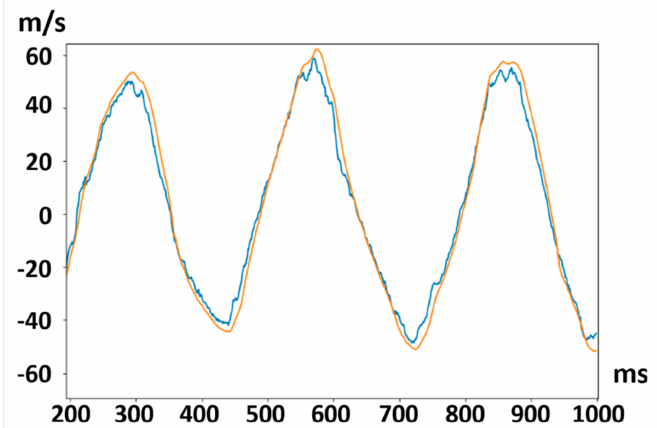
Figure 8. Output response with EKF of 4 layers.